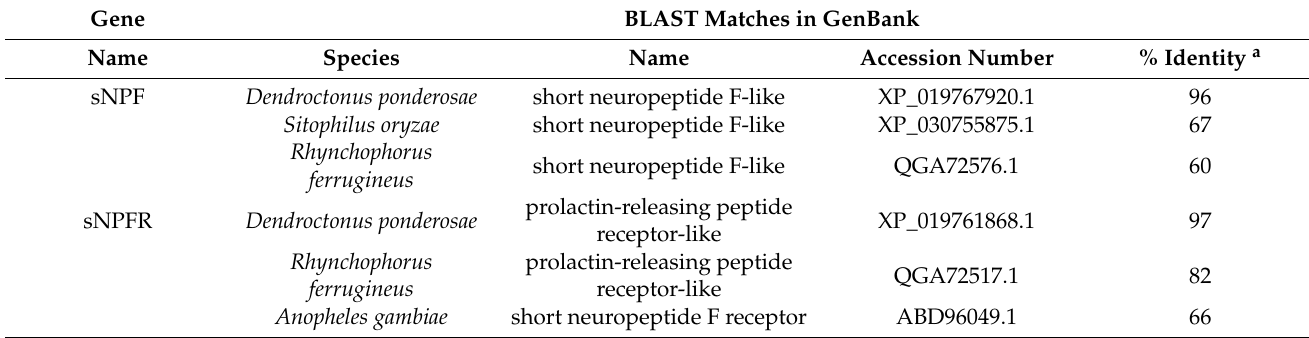
Figure 1. Deduced amino acid sequence of D. armandi sNPF and comparison of the amino acid sequence of the sNPFs with those of other species. They include Dendroctonus ponderosae (Dp sNPF, XP_019767920.1), Sitophilus oryzae (So sNPF, XP_030755875.1), Rhynchophorus ferrugineus (Rf sNPF, QGA72576.1), Aethina tumida (At sNPF, XP_019874673.1), Anoplophora glabripennis (Ag sNPF, XP_018580111.1), and Tribolium castaneum (Tc sNPF, XP_008198705.1). The putative signal region is indicated by black box, and the mature peptide is underlined by a solid red line. The typical C -terminal consensus sequence of sNPFs in Coleoptera is underlined by a solid green line. Identical amino acid residues in all proteins are shown in black; gray parts indicate similar amino acids. Table 2. Amino acid identity of sNPF and sNPFR genes isolated from D. armandi with related gene sequences in other insects.